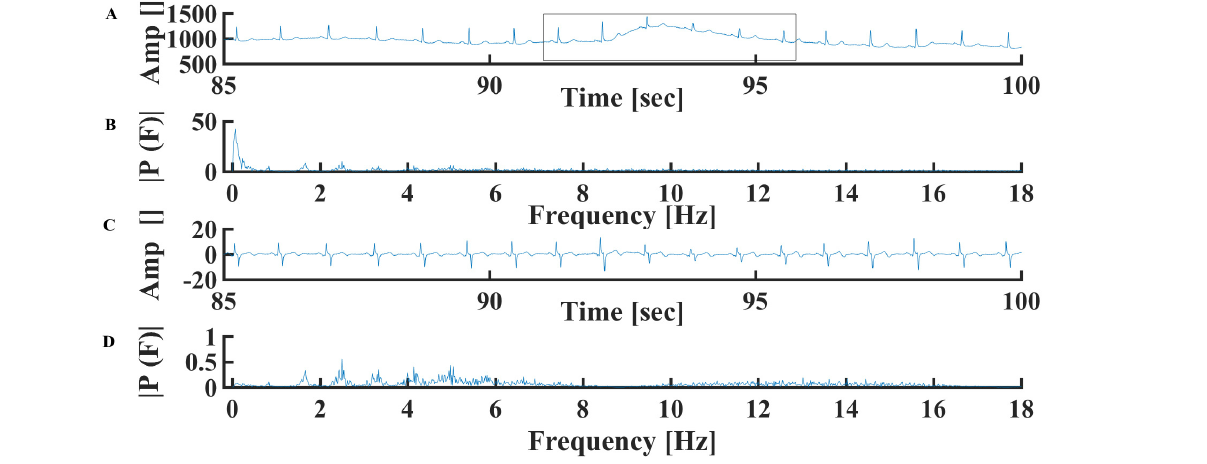
Figure 2. A representative example of a sudden movement artifact in the (A) time and (B) frequency of the ECG signal. Representative examples of ECG signals in (C) time and (D) frequency domains after filtering of the movement artifact. Data from MIT-BIH Arrhythmia Database